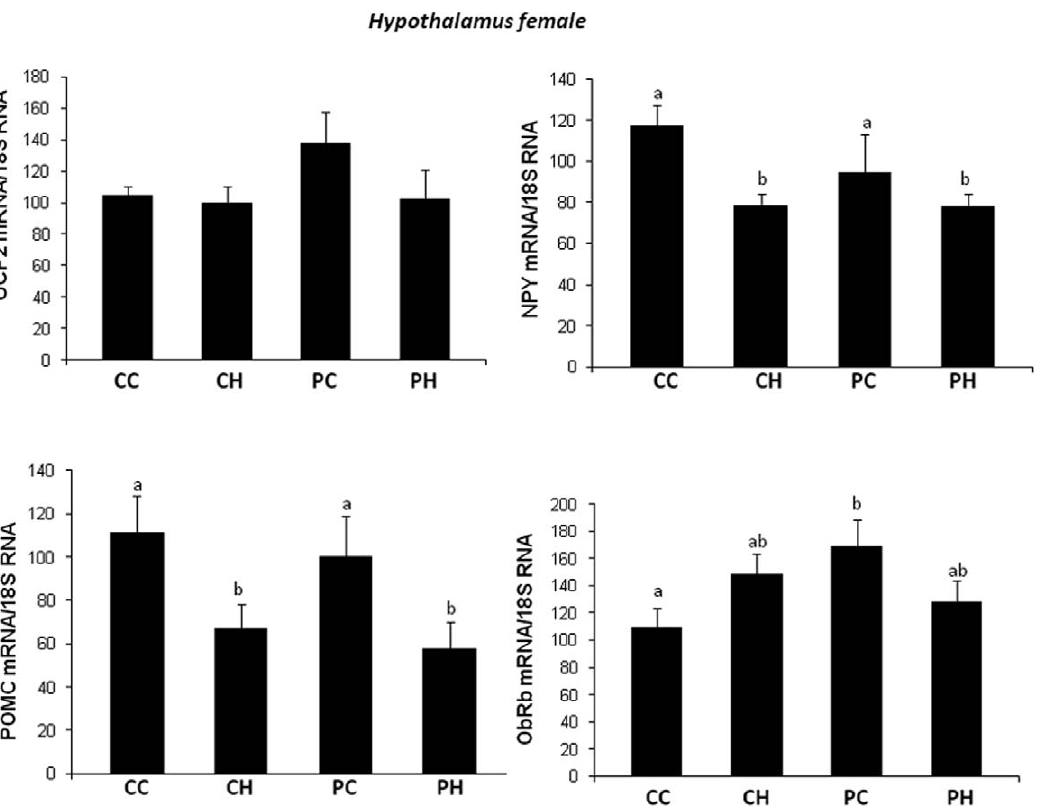
Figure 9. Impact of post weaning diet on hypothalamic gene expression of female pups born to dams fed the control diet (C) or high-fat diet (HF). At weaning offspring were divided into four groups of each gender (CC, CH, PC, PH; n=10) and named according to the post weaning diet (C or P, first letter) and to maternal diet (C or H, second letter). From weaning to 7 weeks of age all groups were assigned to chow diet then swithched to C or P diet for 13 additional weeks. UCP-2, NPY, POMC and ObRb expression were measured by quantitative RT-PCR and results were normalized to 18S RNA. Different superscript letters a,b denote significant differences at p , 0.05 by ANOVA and the Fisher posthoc test.